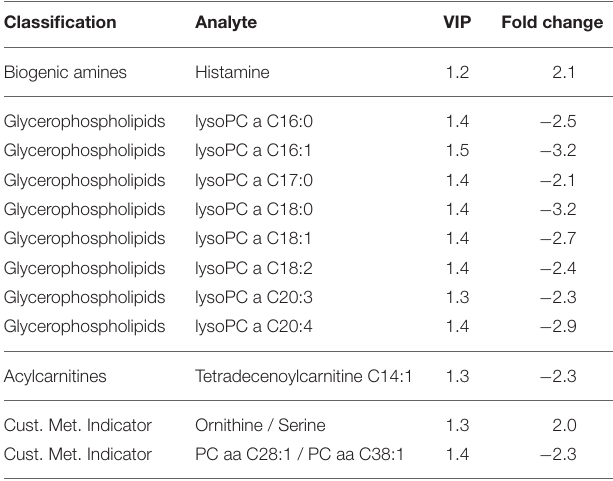
TABLE 2 | List of metabolites identified with VIP and fold change value to have significantly changed at chronic thermal stress (28 ◦ C) when compared to control (24 ◦ C), p <